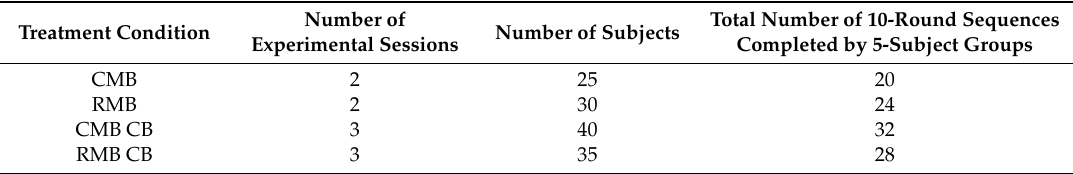
Table 1. Experimental Sessions and